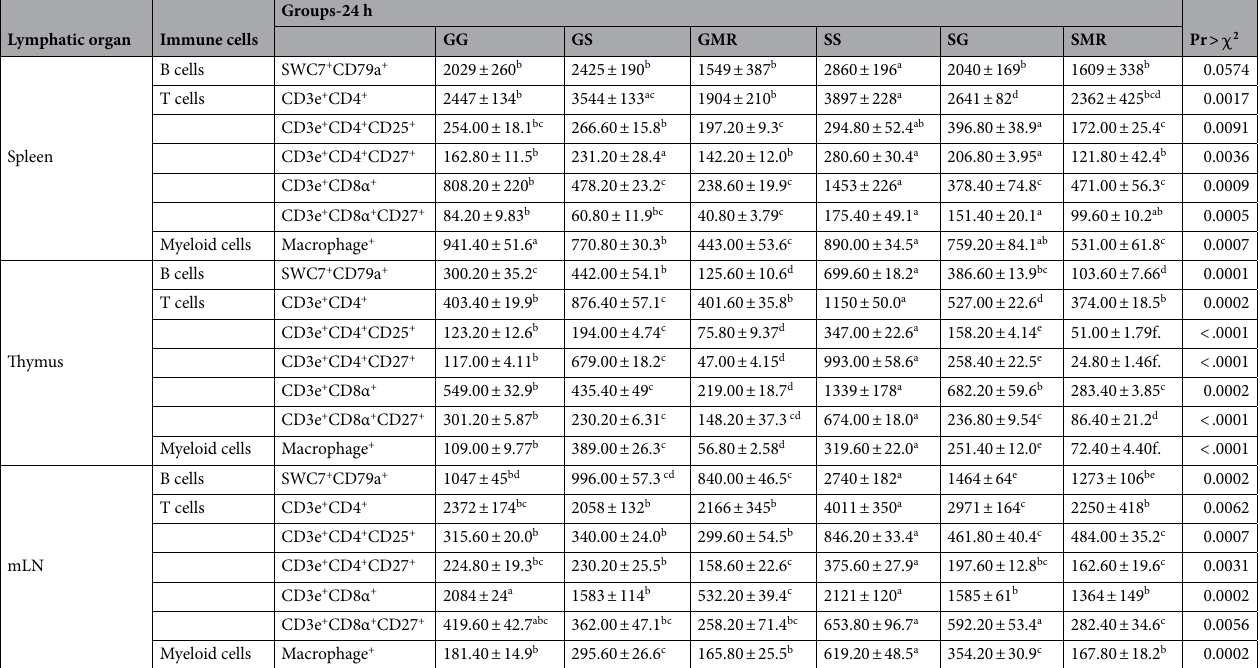
Table 1. Stimulation proliferation index for lymphocytes from lymphoid organs at 24 h of age. The analysis was performed with the Kruskal–Wallis tests and data are shown as Mean ± SEM. a,b,c,d Different superscript letters indicate significant statistical difference ( P ≤ 0.05). The stimulation proliferation (S.I.) index was determined by CFSE dilution and the geometric mean values of the concanavalin A-stimulated duplicates were calculated and divided by the geometric mean values of the PBMC-nonstimulated control